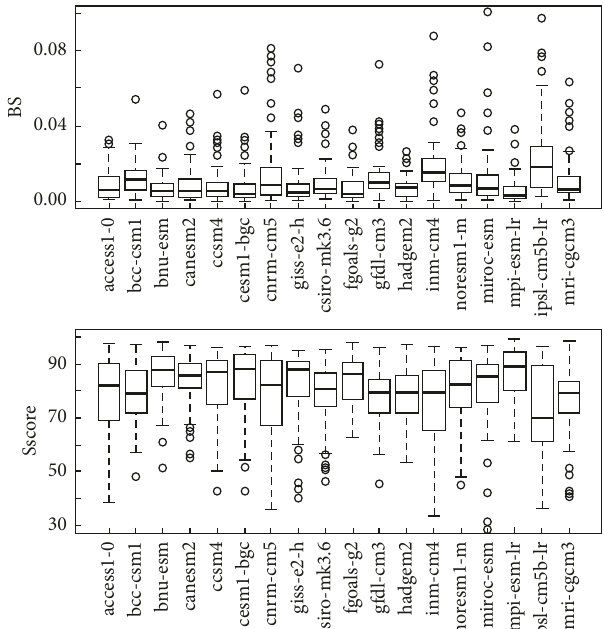
Figure 4: Box plots of BS and Sscore values for the PDF-based performance scores for monthly mean temperatures across all grid points in the Yellow-Huai-Hai basin (unit: %).